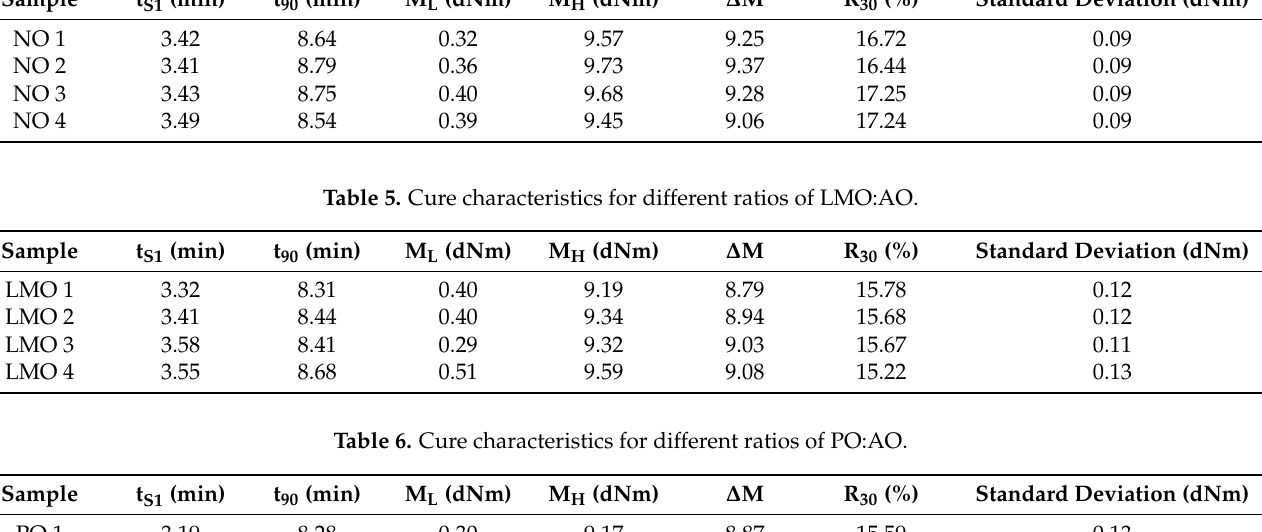
Figure 3. The curing curves of NR-based MREs for different ratios of PO:AO. The values of scorch time (t s1 ), cure time (t 90 ), minimum torque (M L ), maximum Table 4. Cure characteristics for different ratios of NO:AO. torque (M H ), and torque value difference (ΔM) that were obtained from curing curves of different ratios of PBOs are summarized in Table 4 Table 5 Table 6. The moving 𝑆 𝑑 for